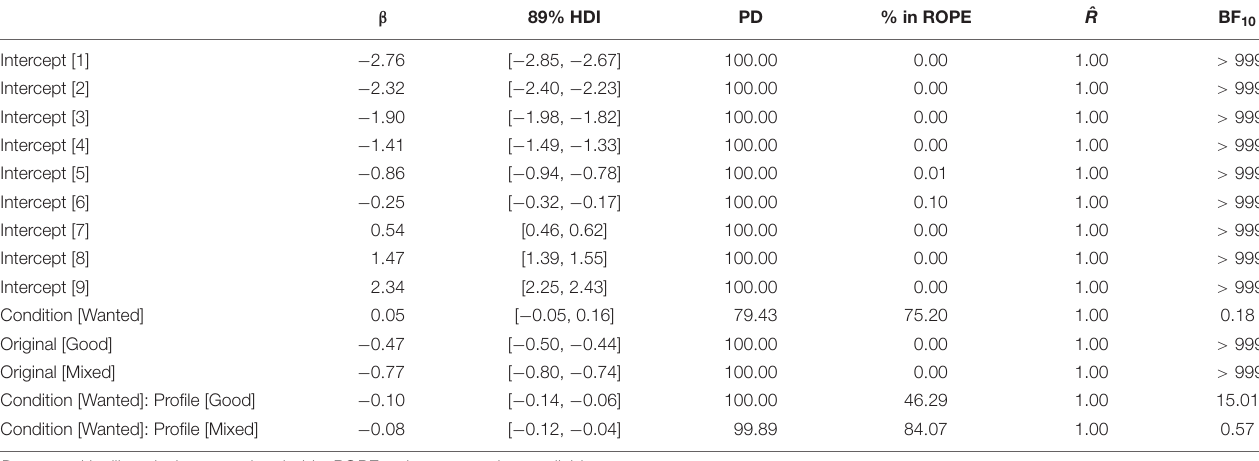
TABLE 15 | Summary of the model fitted to the credibility ratings, considering the experimental condition (Avoided or Wanted) and Profile type (Good, Mixed, and Bad).